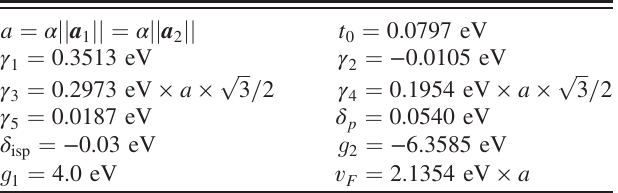
TABLE I. Parameters for setup of the multilayered continuum Hamiltonian. The length of the graphene lattice vectors a 1 the lattice constant α is needed for proper normalization of several hopping